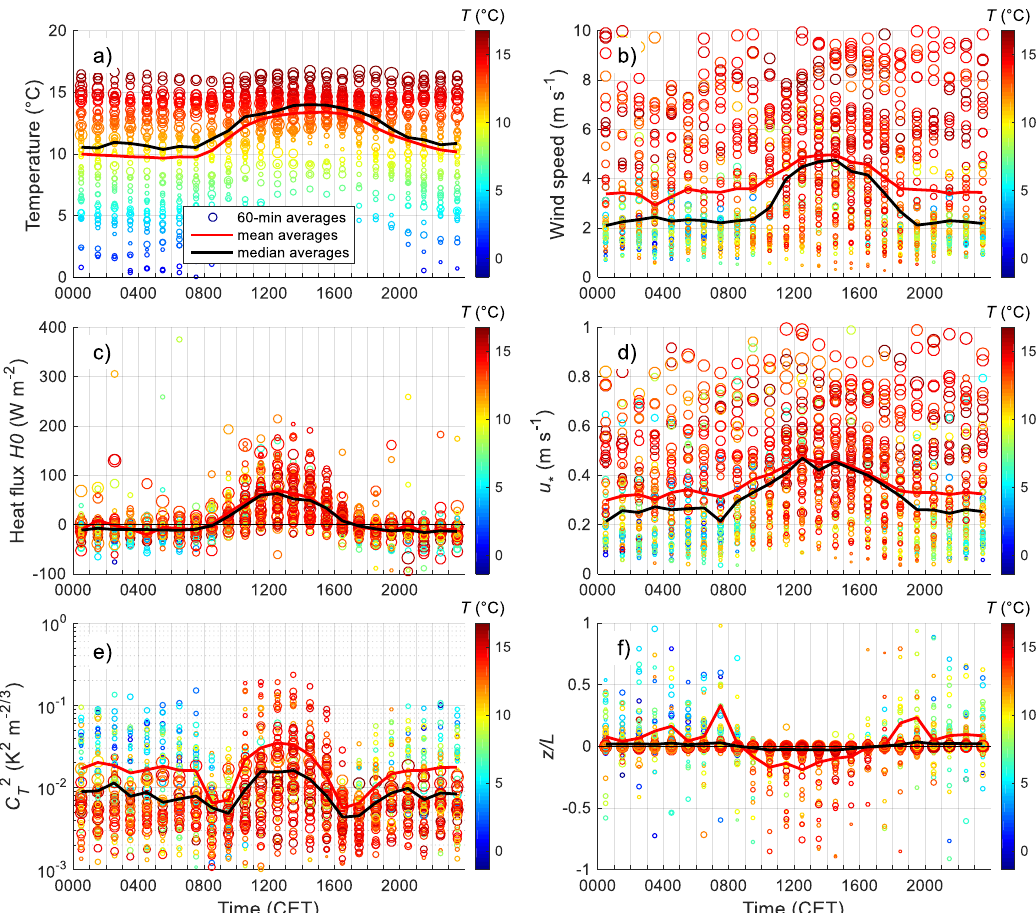
Figure 10. Diurnal cycle of ( a ) temperature, ( b ) wind speed, ( c ) sensible heat flux H 0 , ( d ) friction velocity u * , ( e ) temperature structure parameter C T 2 , and ( f ) stability parameter z / L for the winter months December 2015–February 2016. The colours show the temperature at 1.8 m.